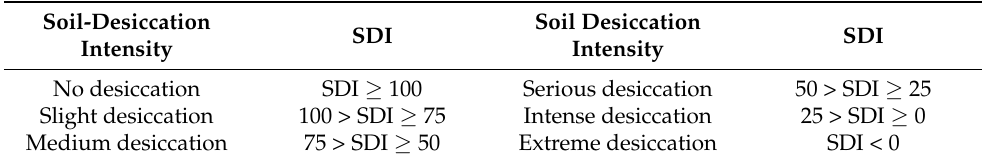
Table 2. Evaluation grade of the soil-desiccation